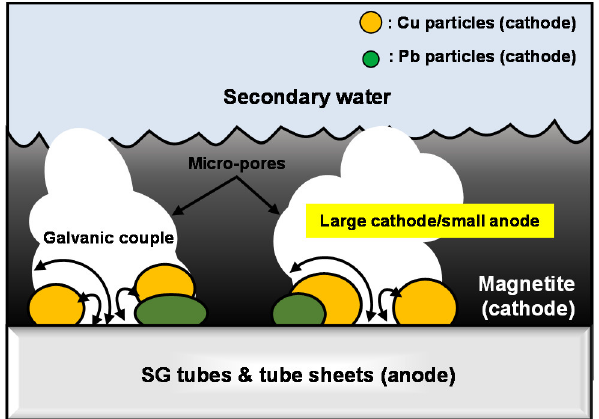
Figure 10. Schematics of the galvanic corrosion process between SG materials and corrosion products exposed to the secondary water.